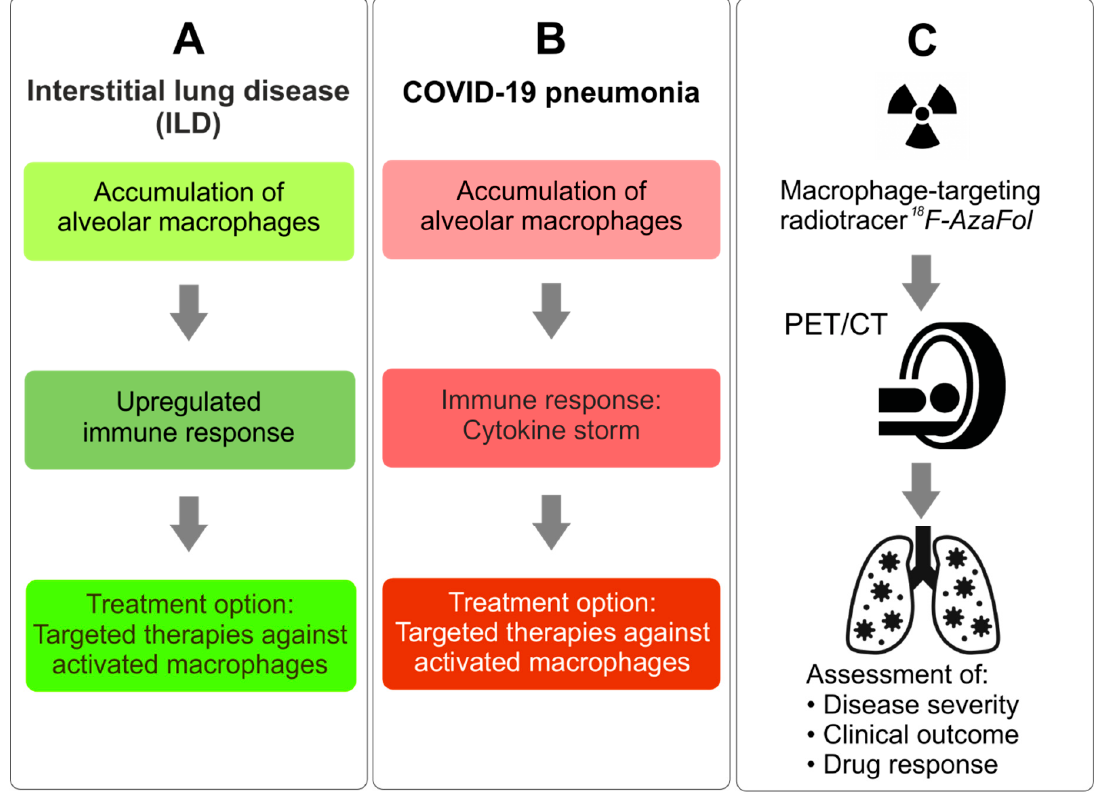
Figure 1. ( A ) Disease progression in interstitial lung disease (ILD). ( B ) Analogy of disease